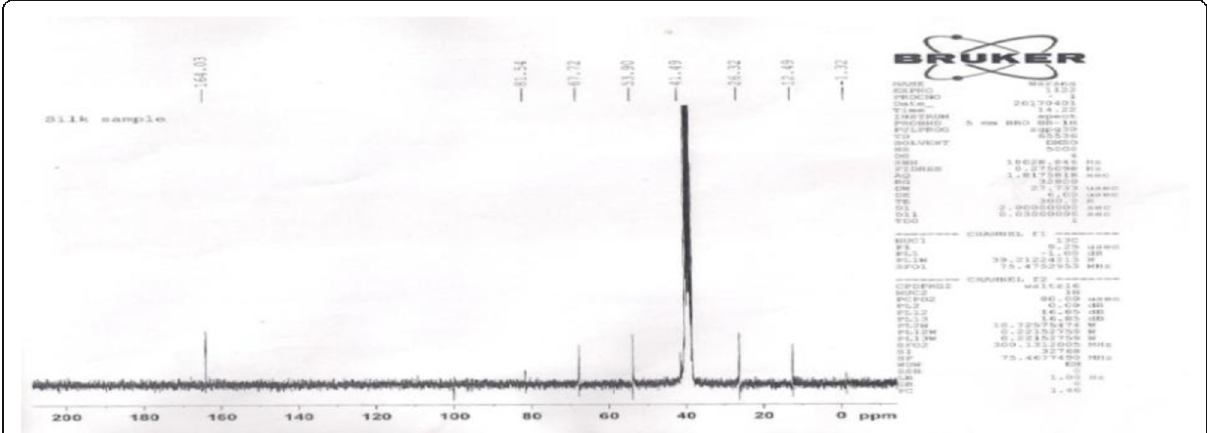
Fig. 4 The 13 C-NMR of bioactive fraction of spider Pardosa brevivulva